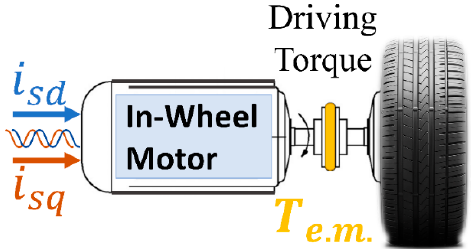
Figure 2. Individual In-Wheel